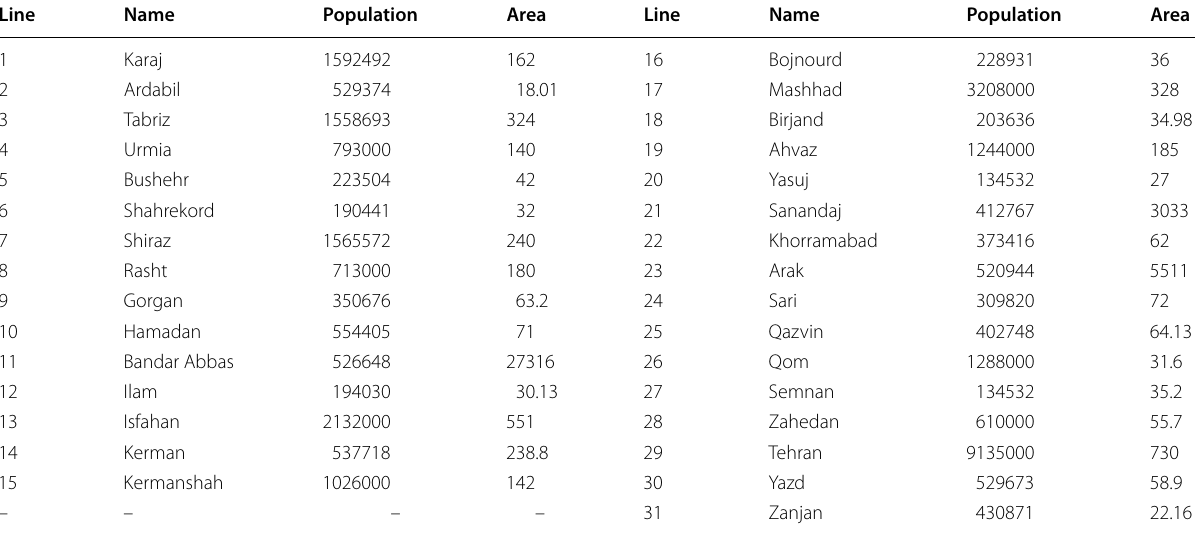
Source: Iranian National Census, 2017, accessible online at www. amar. org.